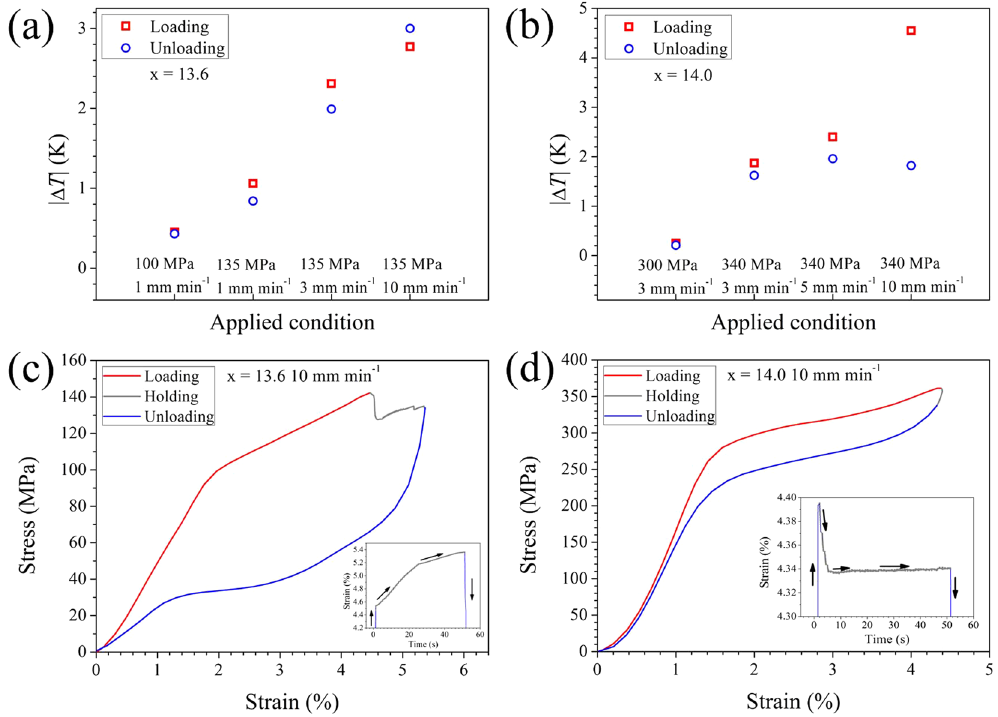
Figure 3. Strain-rate dependence of the maximum temperature changes upon loading and unloading (( a ) x = 13.6, T test = 293 K and ( b ) x = 14.0 T test = 287 K) and corresponding quasi-adiabatic stress–strain responses at 10 mm min − 1 (( c ) x = 13.6 and ( d ) x = 14.0) for Ni 45 Mn 50 − x In x Co 5 samples at room temperature. The insets in 3( c ) and 3( d ) show corresponding strain–time responses during the loading, holding and unloading